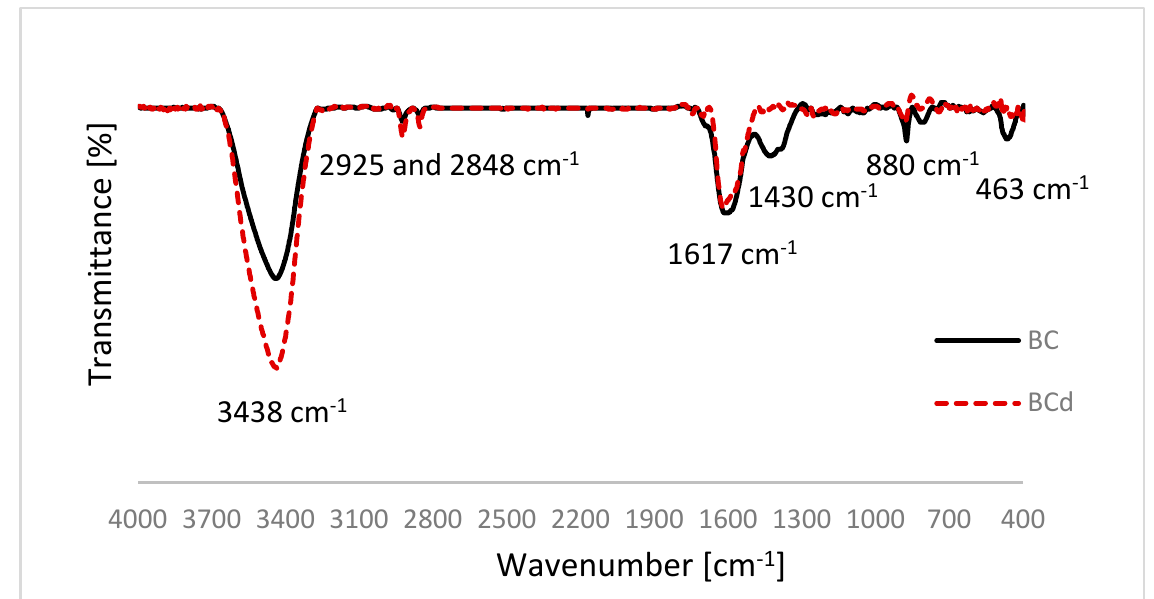
Figure 1. Infrared absorption spectra of the BC (solid line) and BCd (dashed line) biochars.